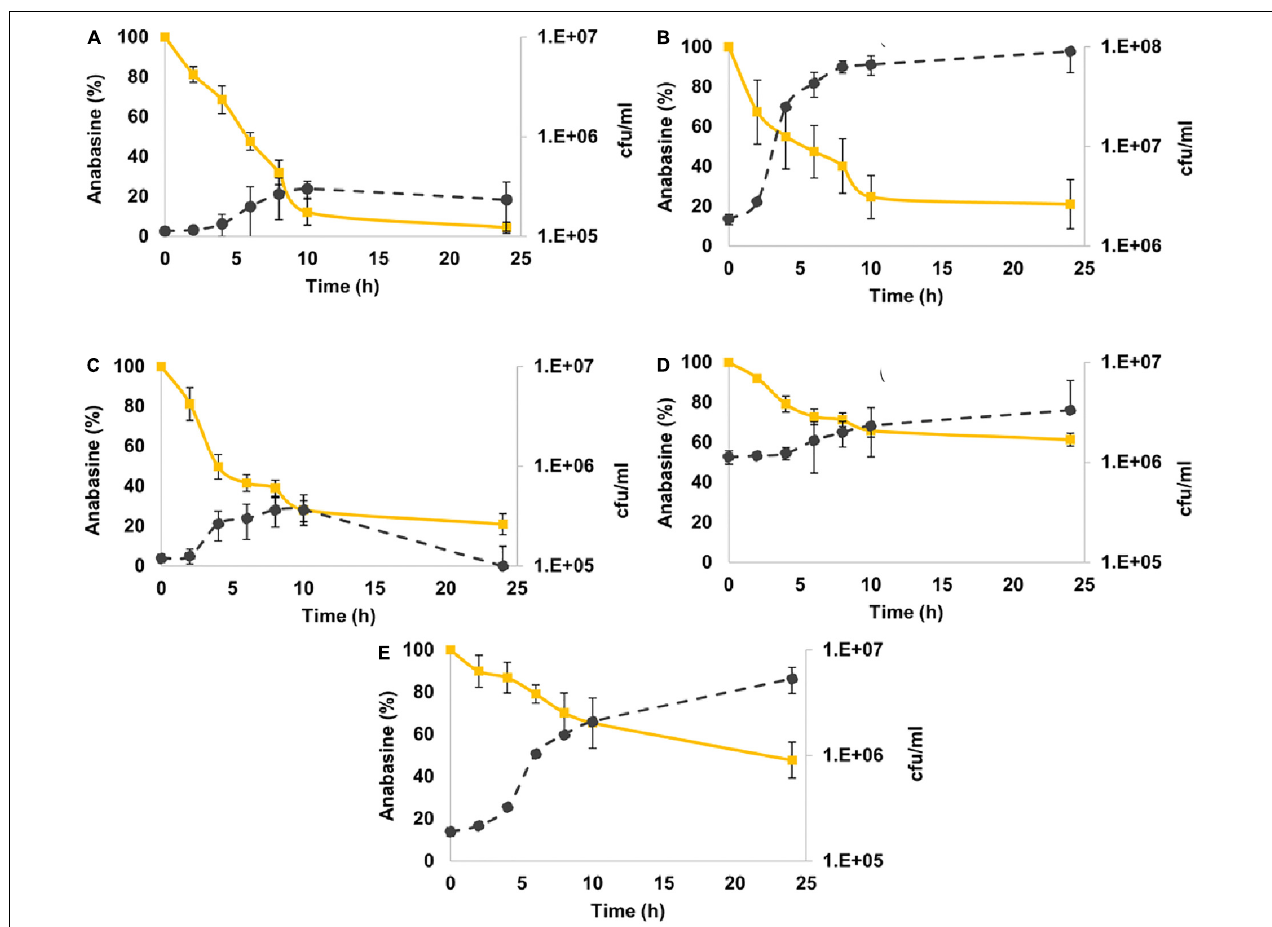
FIGURE 3 | Anabasine degradation by sunbirds’ gut bacterial isolates. (A) Methylorubrum populi (MK348790.1), (B) Chryseobacter gleum (MK348808.1), (C) Enterobacter hormaechei (MK348783.1), (D) Lactococcus lactis (MK348788.1), and (E) Kocuria palustris (MK348831.1). Anabasine percentage curves are in yellow, while the number of bacterial colonies per ml (cfu/ml) curves is in black. Results are presented as mean ±